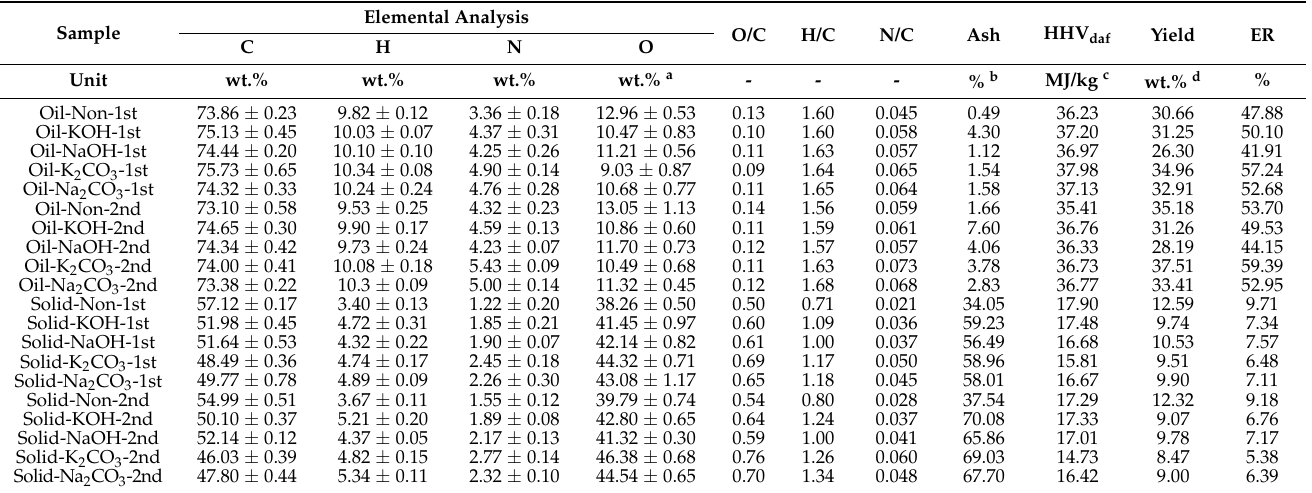
Table 3. Ultimate analysis, ash content, production yield, and ER of bio-crude and solid residue samples. Elemental Analysis Sample O/C H/C N/C Ash HHV daf Yield ER C H N O Unit wt.% wt.%